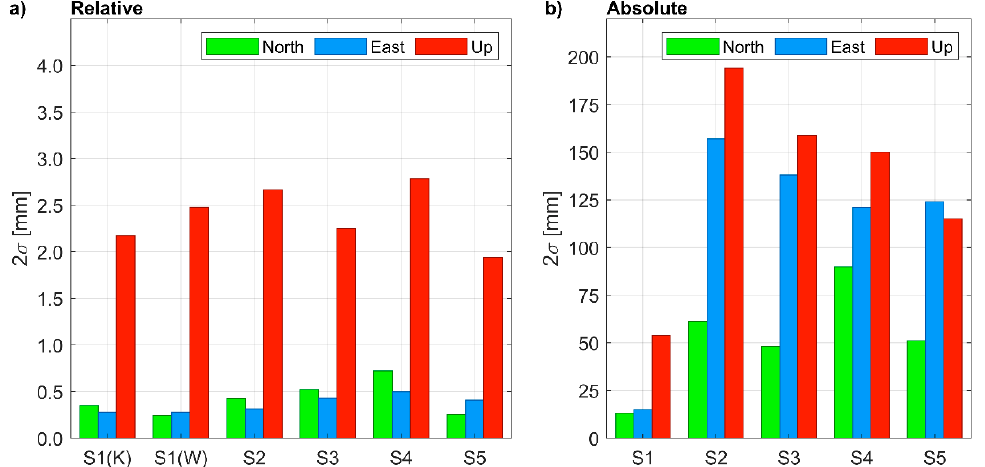
Figure 6. Coordinate uncertainty at 95% (2 σ ) confidence level in: ( a ) relative positioning (the reference station is KALI for S1(K), WIEL for S1(W), WROC for S2 to S5); ( b ) absolute positioning.